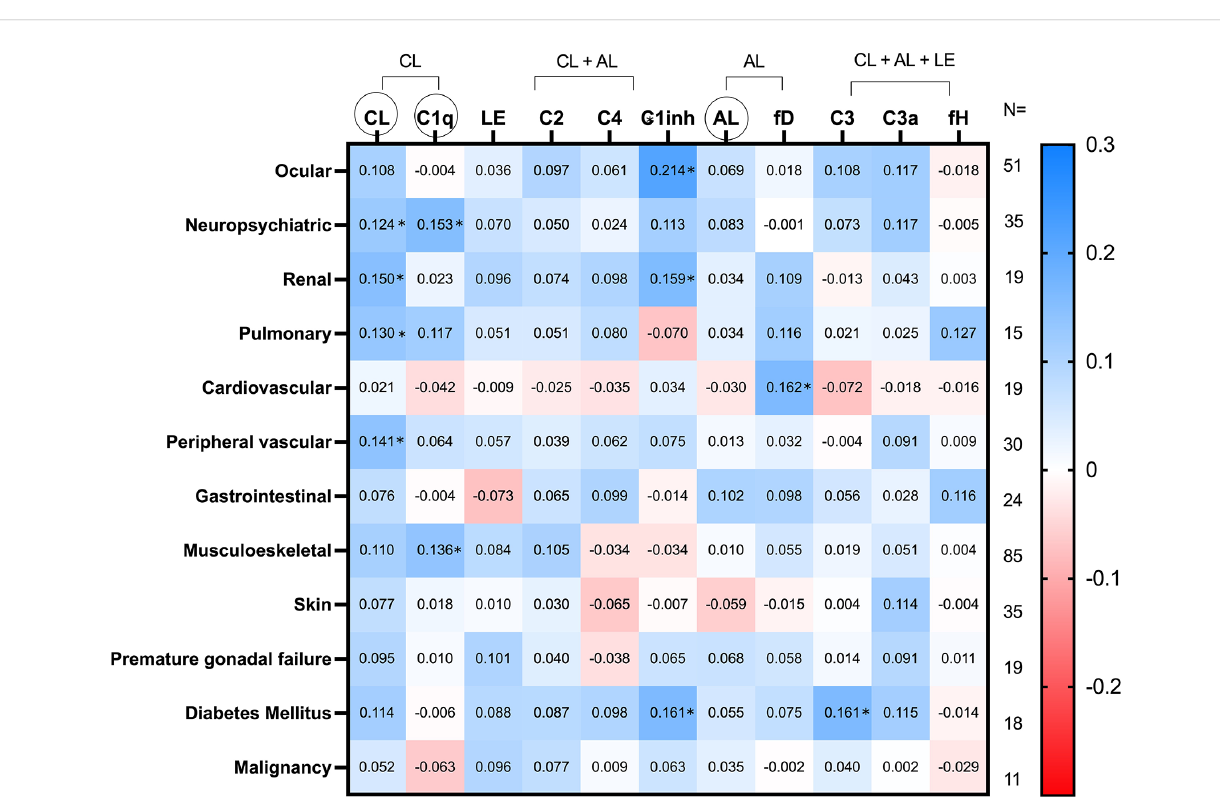
FIGURE 2 Heatmap of SDI items relationship to C pathways activation and serum molecules. Values in the cells represent Spearman ’ s rho coef fi cient (* denotes p value < 0.05). Positive and negative correlations are shown in blue and red, respectively. The number of patients who complied with each item of the SDI is shown in the right margin. CL, classical; AL, alternative; LE, lectin; fD, factor D; fH, factor H. CL, LE and AL in circles refer to the functional tests of these